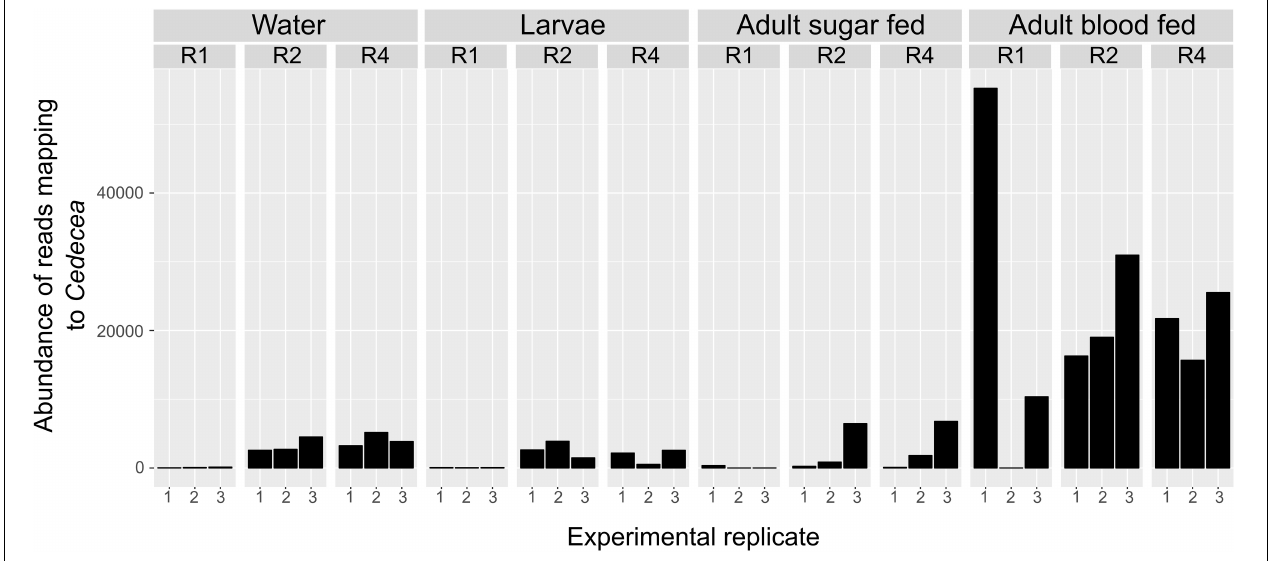
FIGURE 6 | Abundance of Cedecea is significantly affected by larval diet amount in all sample types. Abundance of one OTU that mapped to the genus Cedecea was significantly affected by larval diet amount (W = 58, significant at 0.8 cutoff threshold). Abundance is plotted for all sample types, diet treatments, and biological replicates. Abundance is lowest in R1 in general and higher in R2 and R4 treatments. This is consistent across all sample types and replicates with the singular exception of the first replicate of adult blood fed